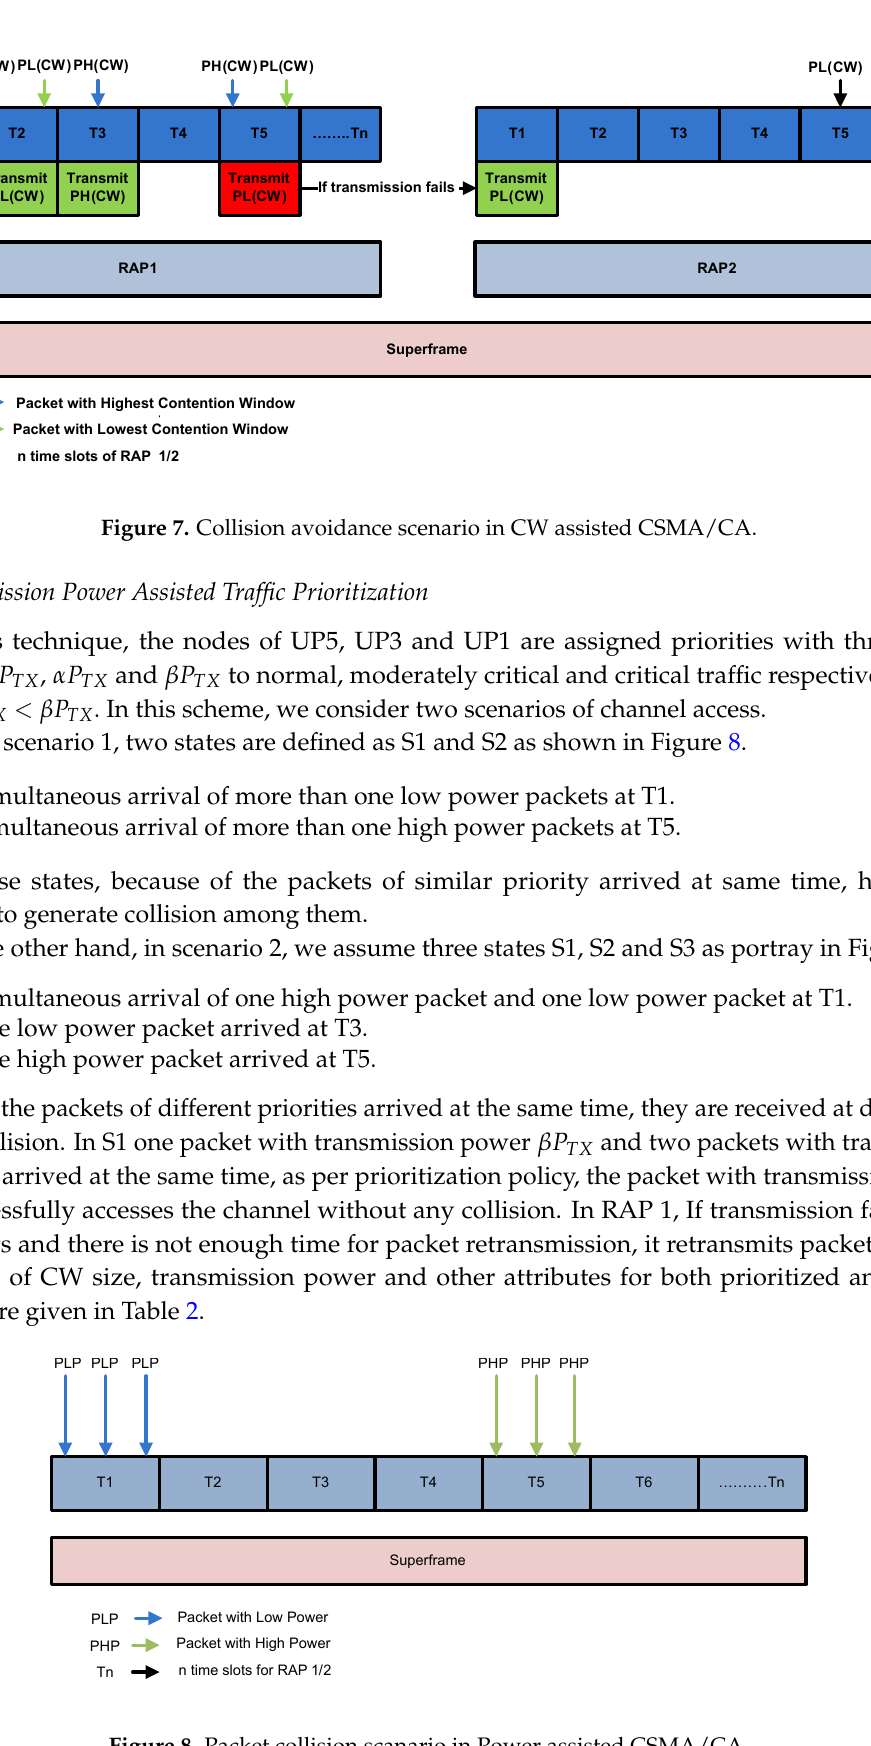
Figure 8. Packet collision scanario in Power assisted